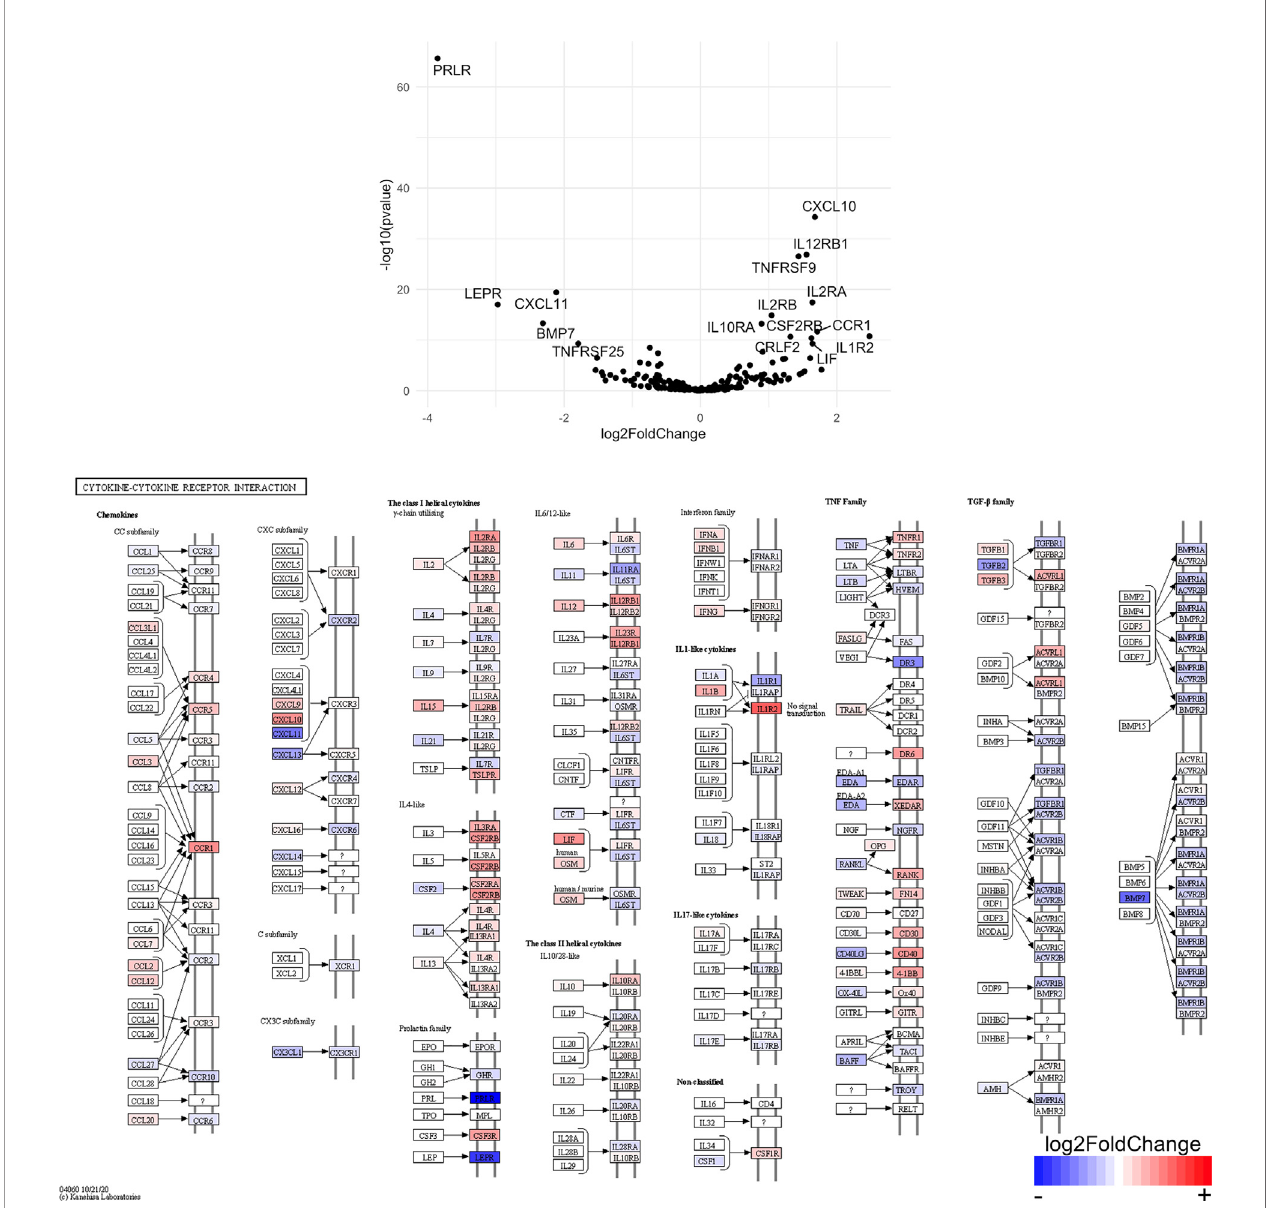
FIGURE 11 | Genes related to cytokine-cytokine receptor interaction are enriched in CD8 + T cells from the CNS of microglia-de fi cient B6J mice compared to microglia-de fi cient SJL mice. C57BL/6J and SJL/J mice were treated with a PLX5622-supplemented diet seven days prior to i.c. TMEV infection and sacri fi ced at 6 DPI for analysis (n = 10 mice per group). Volcano plot of RNA-seq transcriptome data and KEGG map display cytokine-cytokine receptor interaction-related gene expression in enriched CD8 + T cells from the CNS of microglia-de fi cient C57BL/6J mice relative to microglia-de fi cient SJL/J